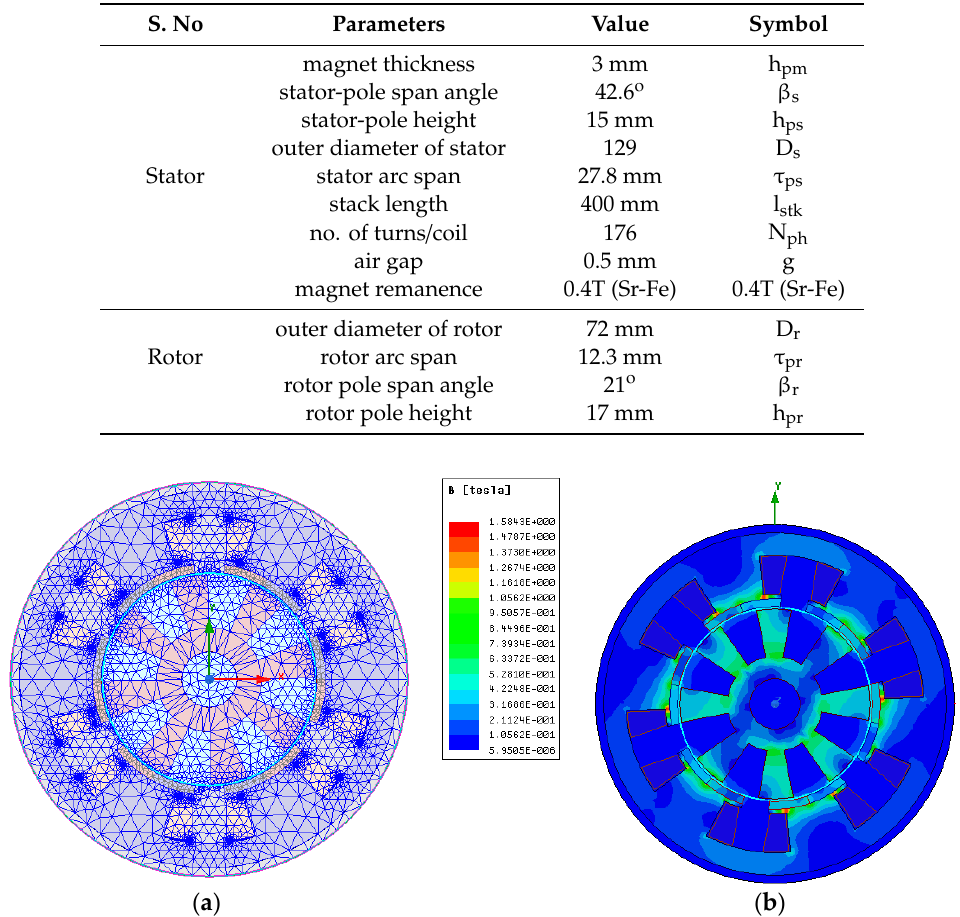
Table 2. Dimensional details of non-rare-earth (NRE) FRM.